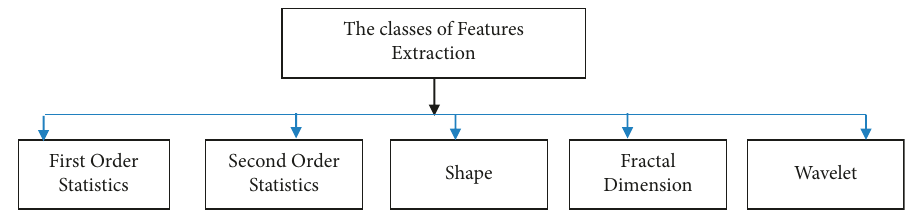
Figure 5: Feature extraction main classes. Table 2: List of eighteen first-order statistical